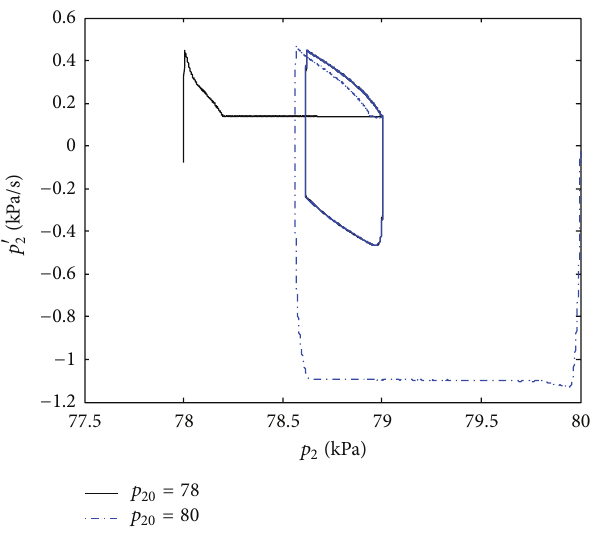
Figure 4: Phase plane trajectories of 𝑝 2 .